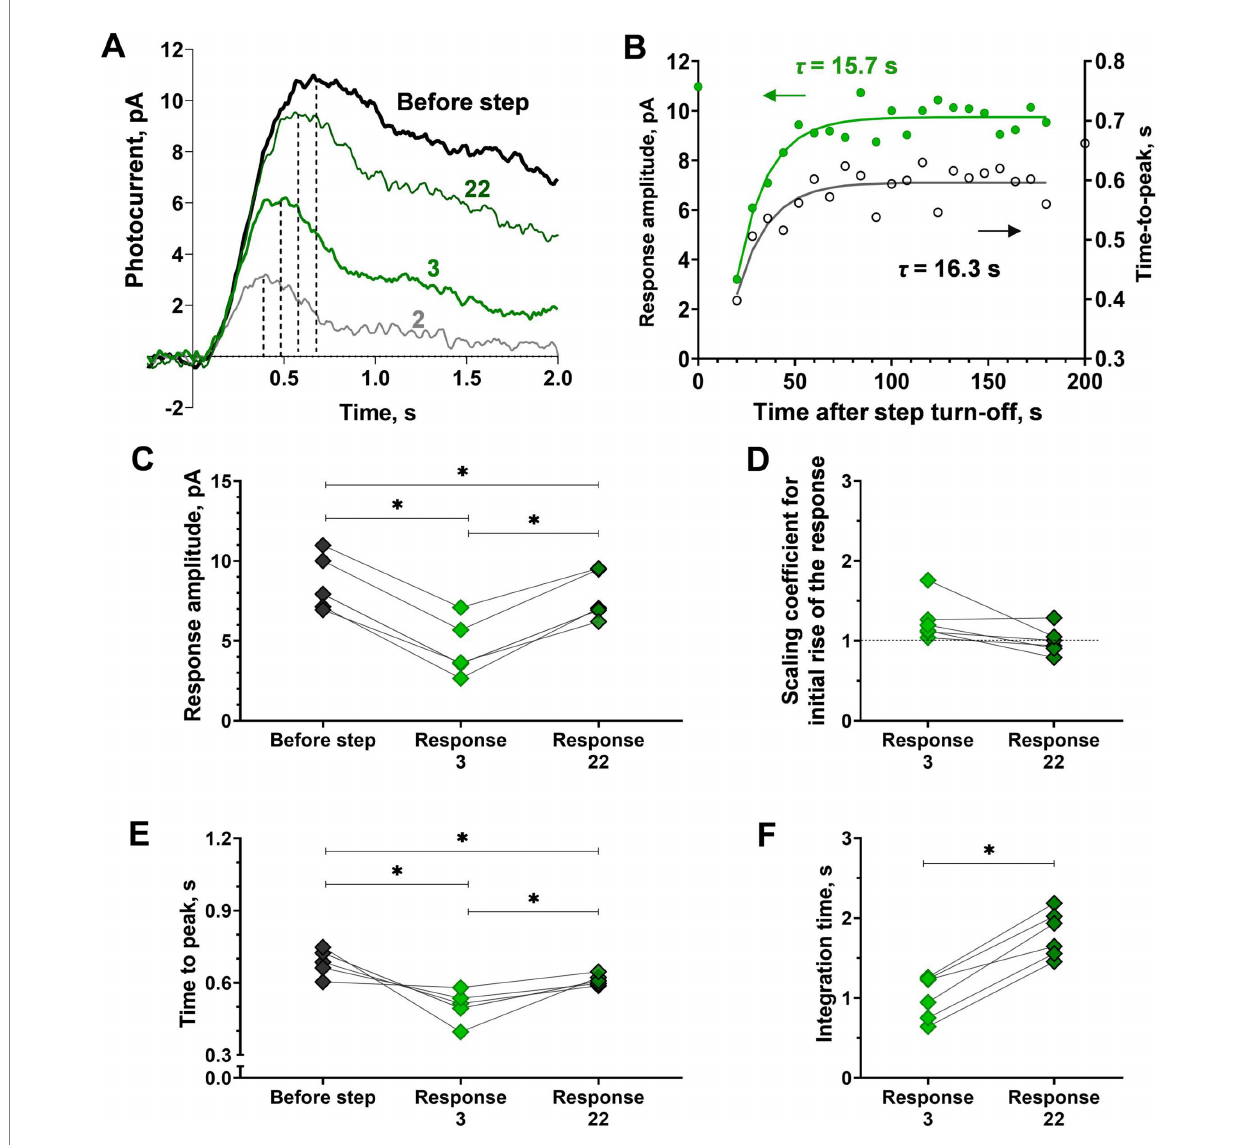
FIGURE 4 Analysis of response kinetics in relation to ‘adaptation memory’ in isolated frog rods. (A) Superimposing of selected responses to the same brief test flashes recorded at different time points after the step turn-off cut from the recording presented in Figure 1A. The bold black curve corresponds to pre-step photoresponse, green curves are the 3rd and 22nd photoresponses recorded after the step turn-off. Dashed lines illustrate the time-to-peak values. (B) Difference in the rate of sensitivity recovery (green circles, left Y-scale) and the time-to-peak recovery rate black empty circles, right Y-axis). For reference, the point plotted at time zero illustrates the pre-step value. (C-F) Difference in response amplitude (C) to several response kinetic parameters: scaling coefficient for rising phase (D) , time-to-peak (E) , and integration time (F) for pre-step response (‘before step’), early response after the step turn-off (‘Response 3’) and last observable response the step turn-off (‘Response 22’). Asterisk * indicates statistically significant differences between groups (Holm-Sidak or paired t-test, p < 0.05). Sample sizes n =